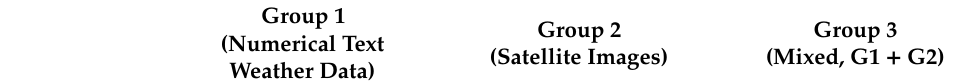
Table 8. Input parameters by each group and